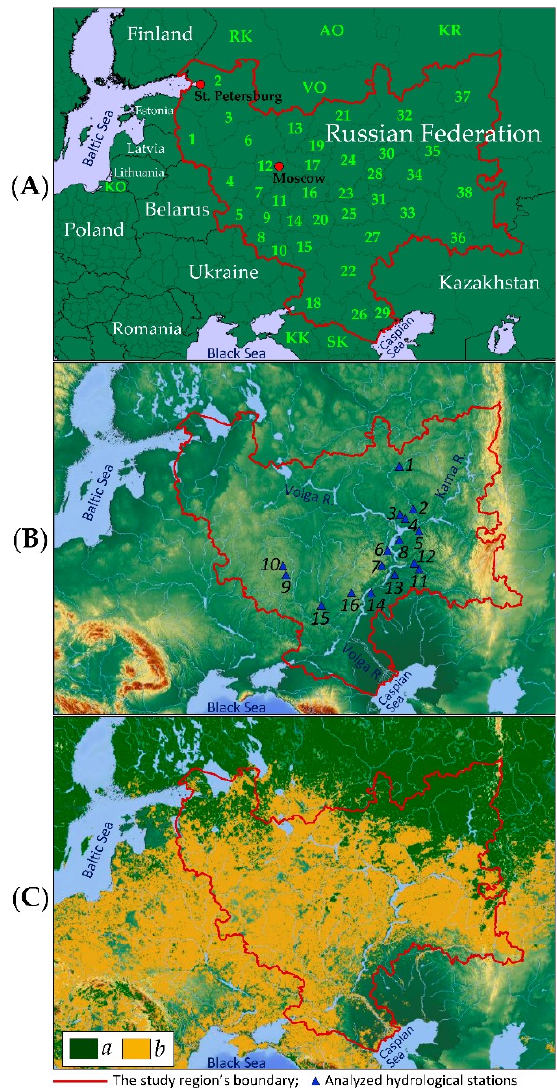
Figure 2. The location of the study region on political ( A ), physical ( B ), and land-cover ( C )